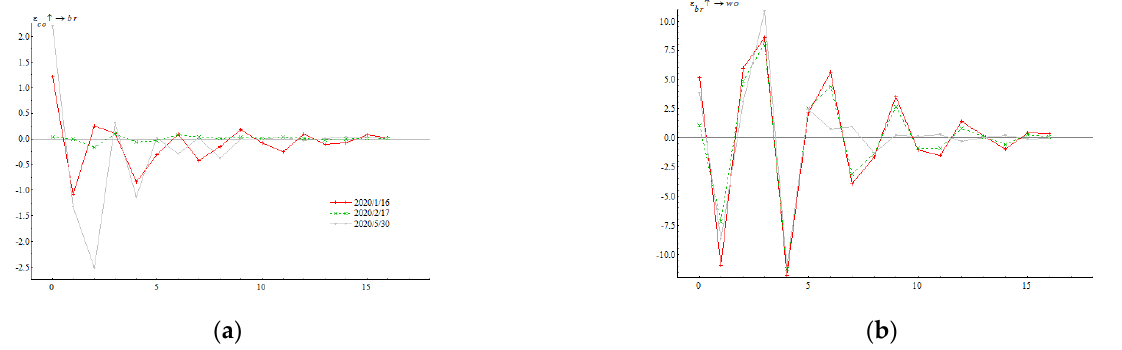
Figure 6. Impulse responses at different points for the set COVID-19, oil prices, and log prices. Note: The abscissa refers to the number of lag periods of the impact, and the ordinate indicates the impulse response values after the shock of one-unit standard deviation. The figure shows the impulse response of oil prices to the pandemic ( a ) and the impulse response of log prices to oil prices ( b ) at different points.